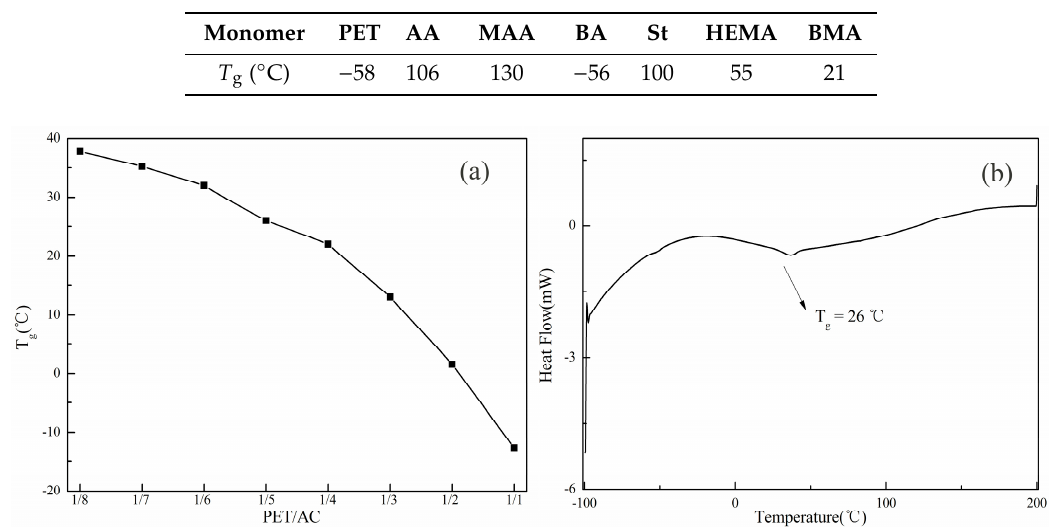
Table 2. The glass transition temperature of the monomer.